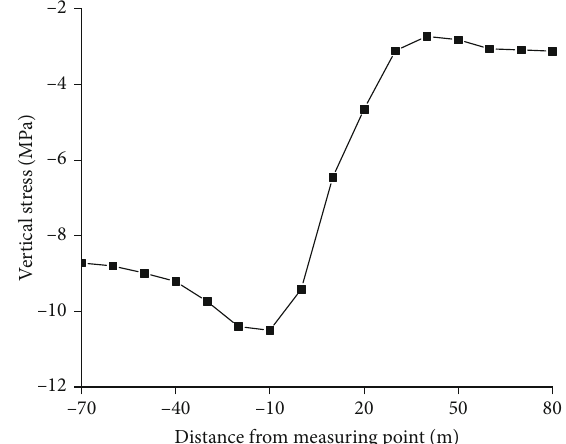
Figure 7: Vertical stress variation of a central measuring point in protected